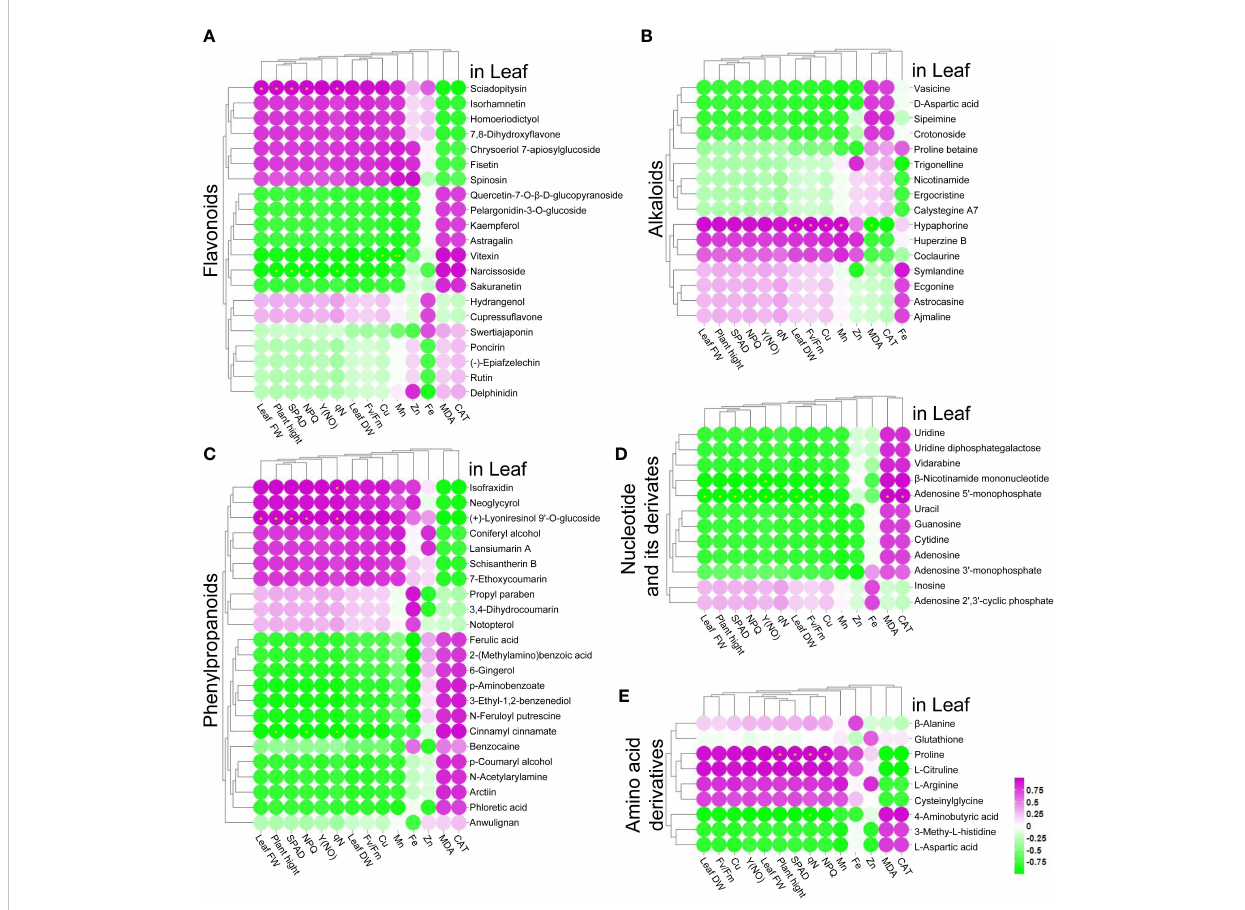
FIGURE 6 (A – E) Correlation analysis of leaf growth parameters with fl avonoids (A) , phenylpropanoids (B) , alkaloids (C) , nucleotides and their derivatives (D) , and amino acid derivatives (E) , * indicates signi fi cantly different values at P < 0.05 according to Student ’ s t